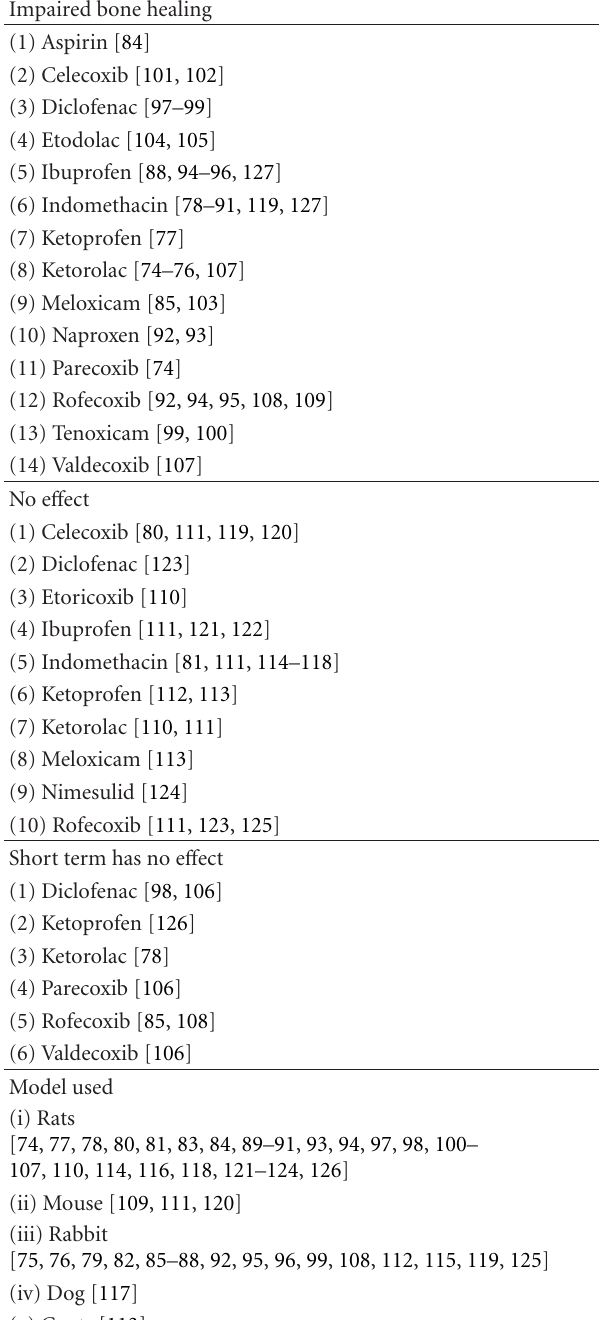
Table 2: Animal studies: agents and model used in relation to the presented e ff